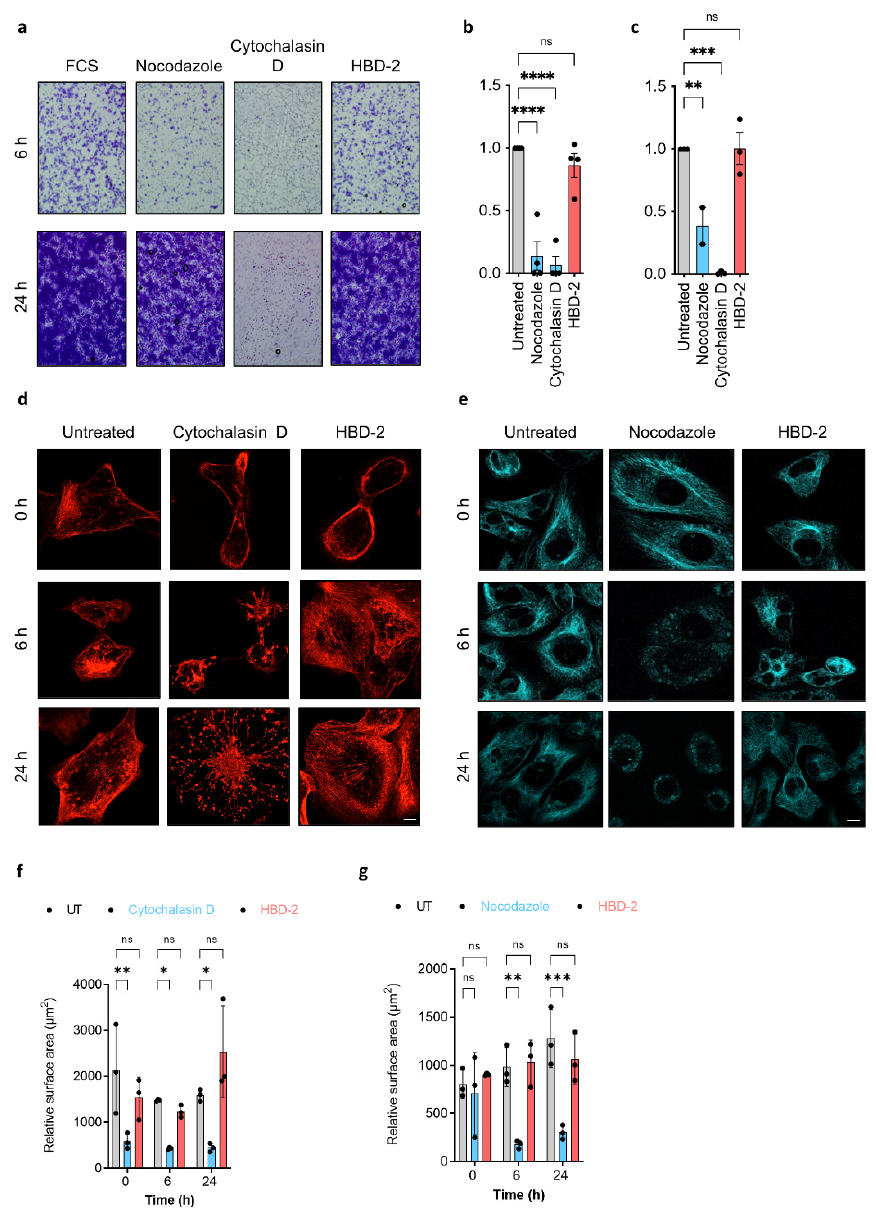
Figure 3. Effect of HBD-2 on tumour cell migration. ( a ) Microscopic images of MDA-MB-231 cells taken over 6 and 24 h representing migrated cells (purple) following various treatments (FCS, nocodazole, cytochalasin D and HBD-2). Quantitative analysis of membranes from a. , over 6 h ( b ) and 24 h ( c ), with all data normalised to No FCS control. Data represent mean ± SEM of at least three independent experiments. ** p < 0.01, *** p < 0.001, **** p < 0.0001, ns: not significant; One-way ANOVA. CLSM of MDA-MB-231 cells stained with SiR-Actin ( d ) and SiR-tubulin ( e ) and imaged over 24 h with HBD-2 (5 μ M), cytochalasin D (10 μ M) and nocodazole (20 μ M). Quantification of CLSM with a relative surface area of actin ( f ) and tubulin ( g ) Data represents mean ± SEM of at least three independent experiments. * p < 0.05, ** p < 0.01, *** p < 0.001, ns: not significant; Two-way ANOVA. Scale bars represent 10 μ m.